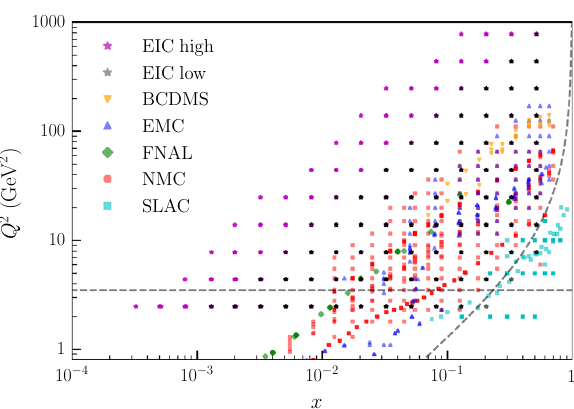
Fig. 23 Same as Fig. 1, but now including also the kinematic cover- age of the EIC pseudo-data used in this study and listed in Table 6. We indicate the coverage of the “high-energy” and “low-energy” EIC scenarios, corresponding to electron energies E e = 20 GeV and 5 GeV, respectively